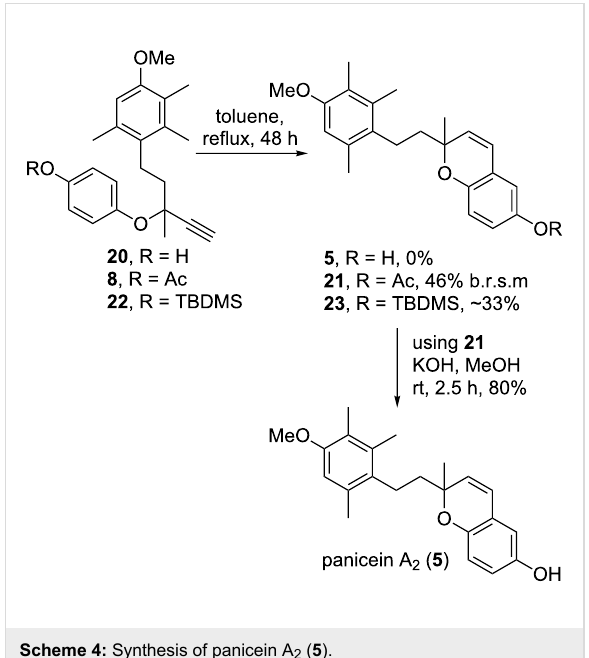
Scheme 4: Synthesis of panicein A 2 ( 5